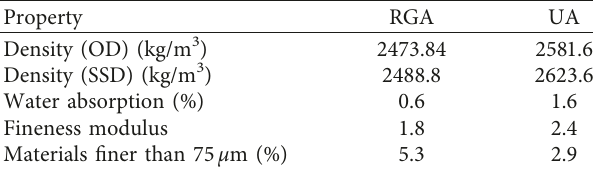
Table 1: Physical properties of the